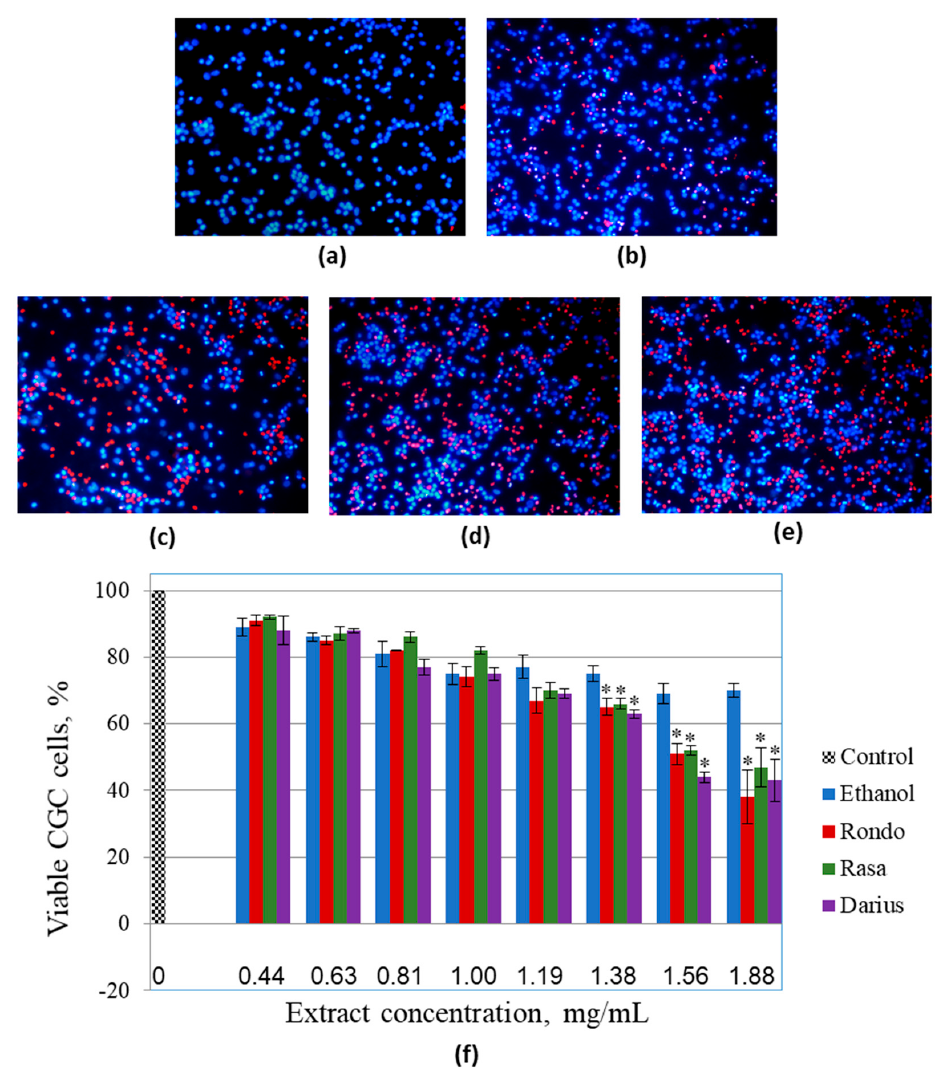
Figure 3. The effect of the extracts from leaves of different Japanese quince cultivars on viability of cultivated primary rat cerebellar neuronal-glial cells. ( a – e ) Representative images of nuclei stained with Hoechst33342 and propidium iodide after extract treatments: ( a ) Untreated control, ( b ) sample treated with 125 µ L/mL of the solvent ethanol; ( c – e ) samples treated with 1.19 mg/mL extracts from ‘Rondo’, ‘Rasa’, and ‘Darius’ cultivars, respectively; ( f ) quantitative summary of viability data presented as averages with standard deviation, * indicates significant difference compared with the samples treated with the same amount of